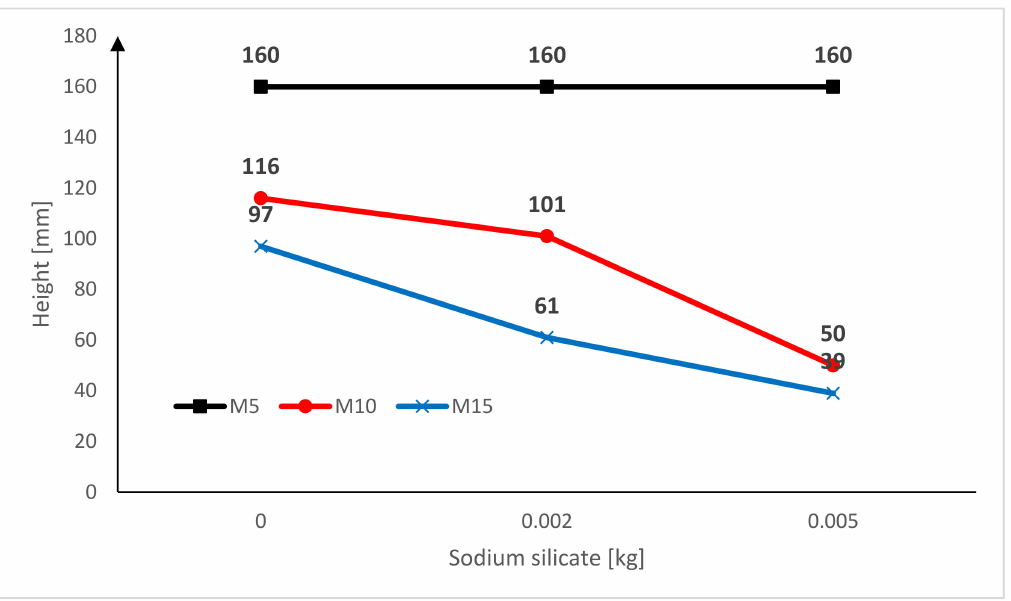
Figure 14. The effect of the sodium silicate on the capillary suction index of the M5, M10, M15 cement mortar bars after 120 h of being